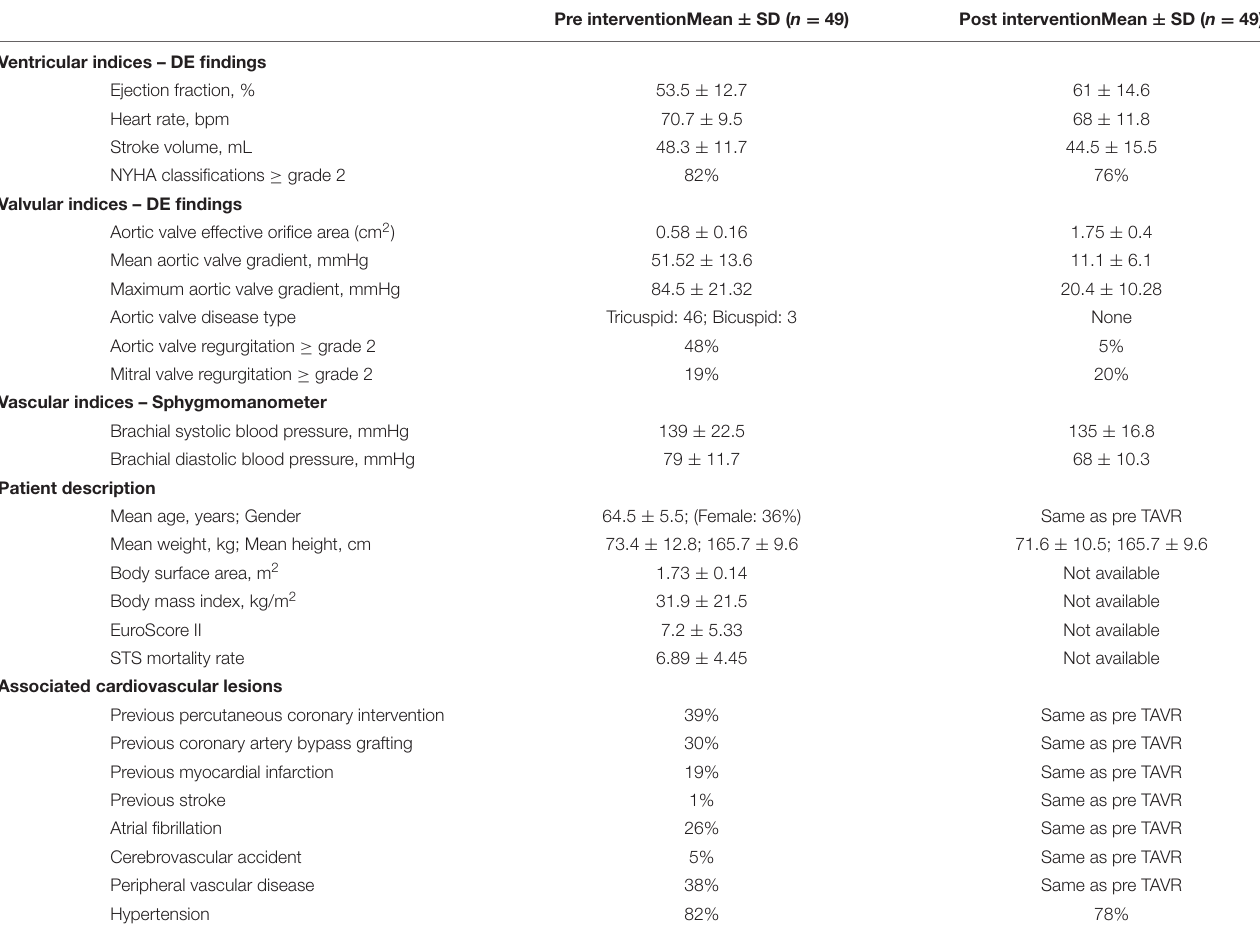
TABLE 2 | Patient